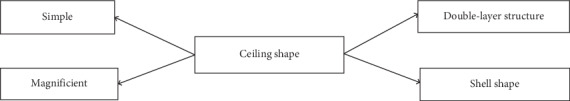
A single evaluation project construction diagram.